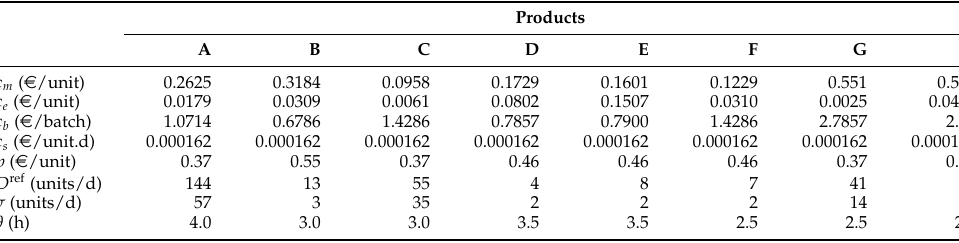
Table 1. Data for the bakery unit optimization model (A, B, ..., H are